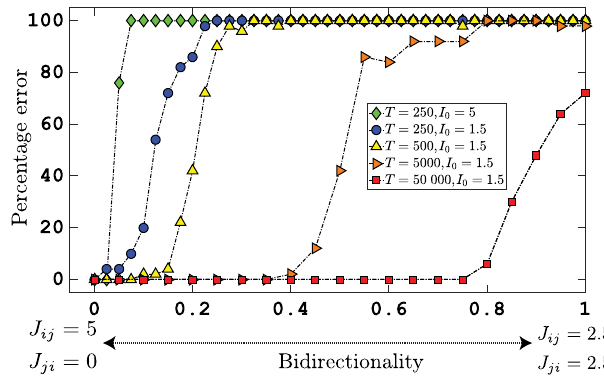
FIG. 15. Error versus bidirectionality. The degree of bidirec- tionality J ji =J ij of the carry-out ( j ) to carry-in ( i ) link between the full adders is systematically varied while keeping the sum J J ij þ ji constant. In each case the sum is obtained from the statistical mode (or majority vote) of T time samples over 50 trials. The y axis shows the fraction of trials that yield the wrong result. Note that for large I 0 and small T , error-free operation is obtained only if bidirectionality is close to zero, similar to standard digital circuits. But with I 0 ¼ 1 . 5 and T ¼ 50000 , error-free operation (at least for 50 trials) is obtained even with ≈ 75%